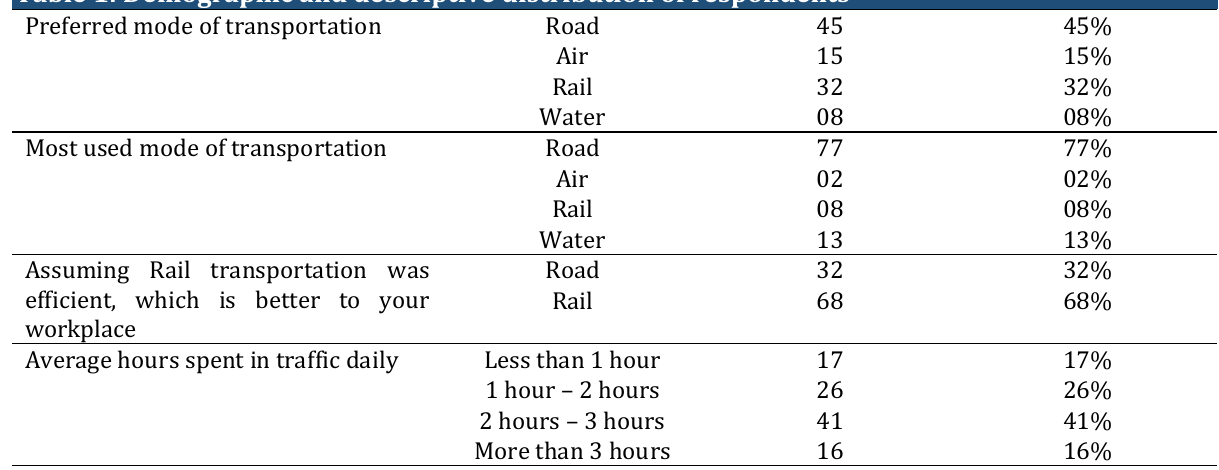
Table 1: Demographic and descriptive distribution of respondents Preferred mode of transportation